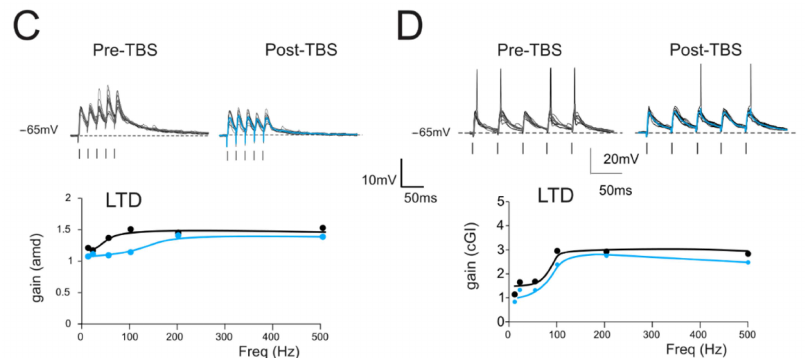
Figure 3. Gain modulation by synaptic plasticity ( A ) Top . Traces (10 repetitions) obtained from a GrC showing subthreshold responses to repetitive stimulation at 50 Hz in the control (left) and following the delivery of TBS (right). Average traces (thick, gray and red) show that, in this cell, TBS increased the average response, as expected from the expression of LTP. Bottom. Gain curve of the cell shown in the top traces before (black) and after LTP (red) induction. ( B ) Top. In a different cell, there was repetitive stimulation at 20 Hz (10 traces) obtained from a GrC showing firing responses to repetitive stimulation in the control (left) and following the delivery of TBS (right). Average traces (thick, gray and red) show that, in this cell, TBS increased the number of spikes and decreased the spike delay and variability. Bottom. Gain curve of the cell showed in the top traces before (black) and after LTP (red) induction. ( C ) Top. Traces (10 repetitions) obtained from a GrC showing subthreshold responses to repetitive stimulation at 50 Hz in the control (left) and following the delivery of TBS (right). Average traces (thick, gray and blue) show that, in this cell, TBS decreased the average response, as expected from the expression of LTD. Bottom. Gain curve of the cell shown in the top traces before (black) and after LTP (blue) induction. ( D ) Top. In a different cell, there was repetitive stimulation at 20 Hz (10 traces) obtained from a GrC showing firing responses to repetitive stimulation in the control (left) and following the delivery of TBS (right). Average traces (thick, gray and blue) show that, in this cell, TBS decreased the number of spikes and increased the spike delay and variability. Bottom. Gain curve of the cell shown in the top traces before (black) and after LTP (blue) induction.